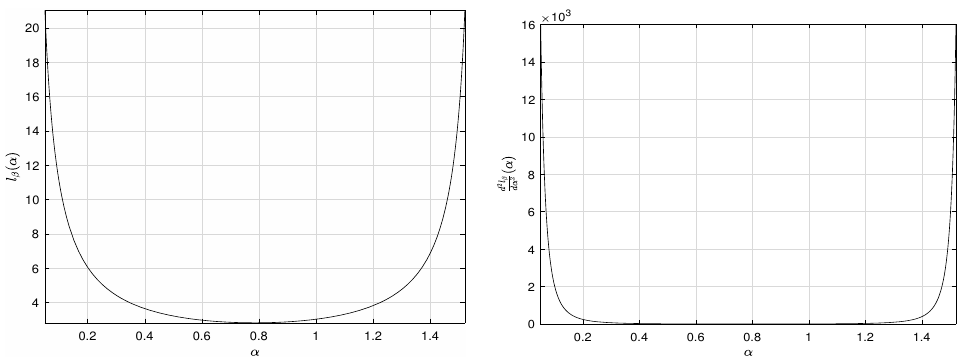
, d 1 = 1 and d 2 = 1 on the 2